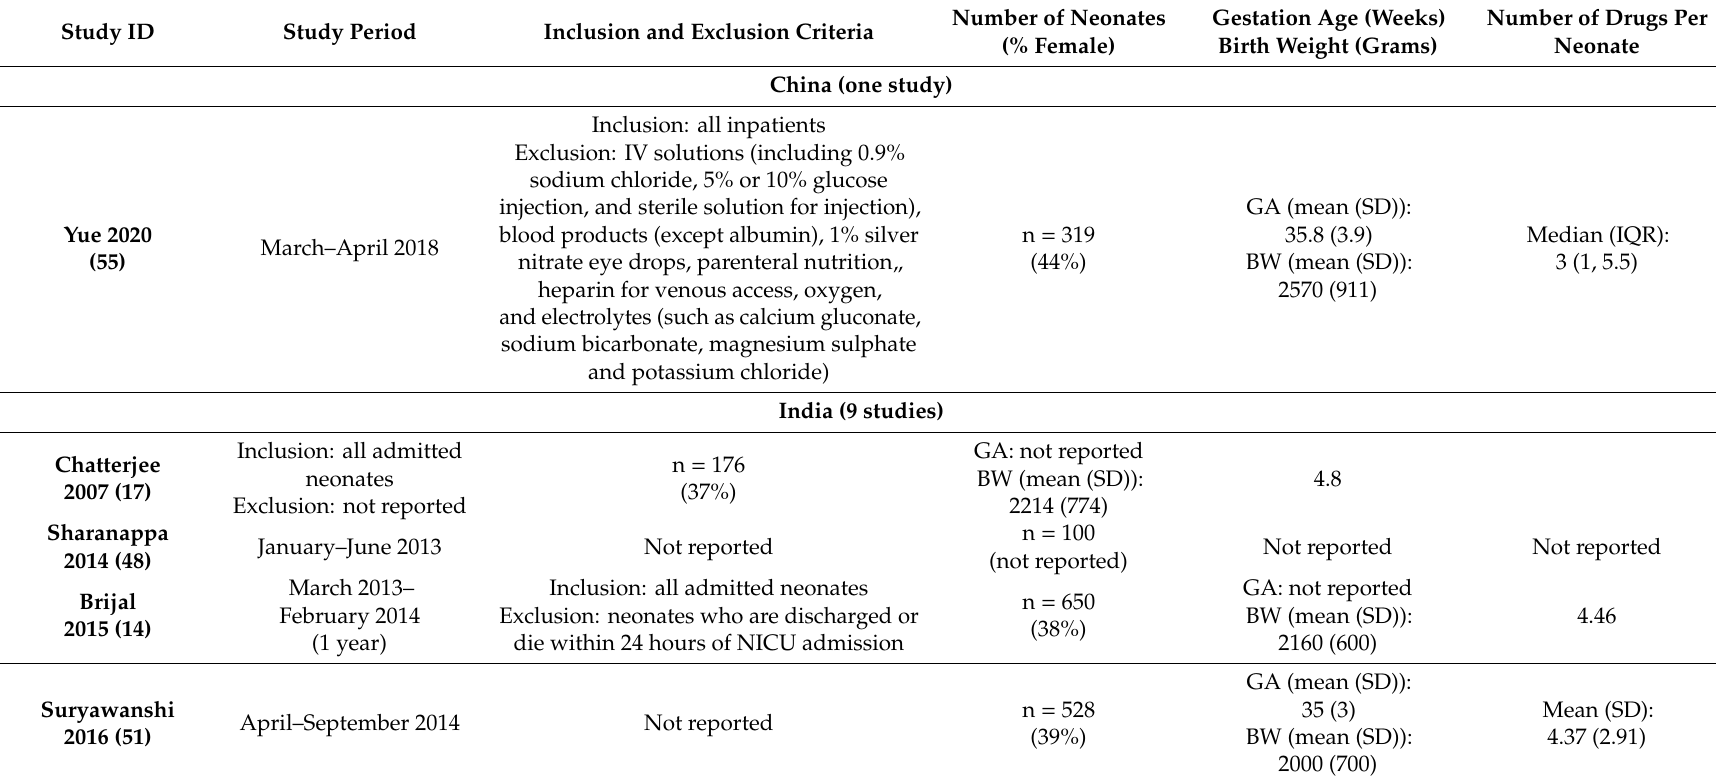
Table A5. Studies of drug utilization in Asia (11